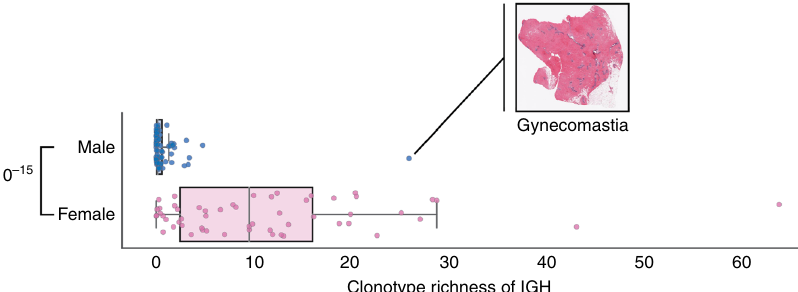
ImReP algorithm . ImReP is a computational approach to assembling CDR3 sequences and detecting corresponding V(D)J recombinations from B- and T-cell receptors. ImReP consists of two stages. In the fi rst stage, ImReP infers the CDR3 sequences from reads that simultaneously overlap V and J gene segments. We de fi ned the CDR3 as the sequence of amino acids between the cysteine on the right of the junction and phenylalanine (for IGK or IGL) or tryptophan (for IGH) on the left of the junction. We fi rst converted the read sequences from nucleotides to amino acids. We scanned the amino acid sequences of the read and determined the putative CDR3 as a sub-sequence of the read, starting from cysteine (C) and ending with phenylalanine (F) (and tryptophan [W] for IGH). The reads con- taining the described substring were considered candidate CDR3 reads. We denoted n to be the length of the read. We denoted the coordinates of the putative CDR3 string to be x and y , corresponding with the start and the end of the CDR3 sequence, respectively, in the read coordinates. This way each candidate CDR3 read is composed of three parts. The fi rst part of the CDR3 read contains a pre fi x of the read, which potentially overlaps with the suf fi x of V gene. The pre fi x